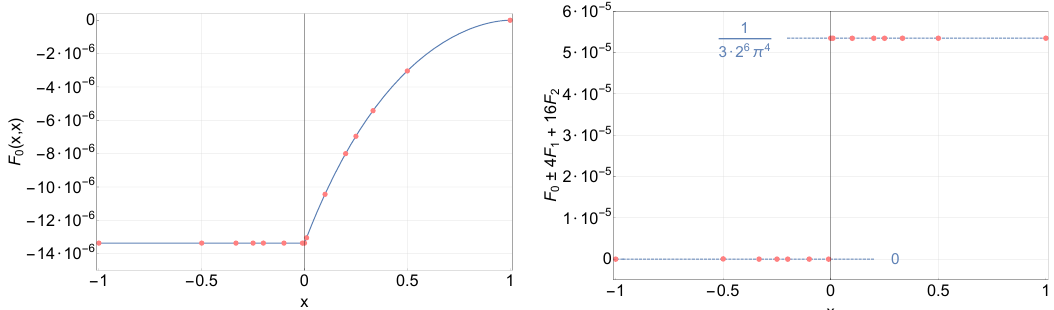
Figure 4. The left plot shows the 0 -channel after numerical integration (dots) and after resumma- tion (solid line) as given by eq. (4.14) in the collinear limit z = ¯ z . We observe a perfect match, and note that F is constant for negative x . The right plot shows the reduced Ward identities in the 0 collinear limit for the F -functions computed numerically (dots). The constant behavior is exactly c what is expected from eq. (2.10). The dashed lines are here to guide the